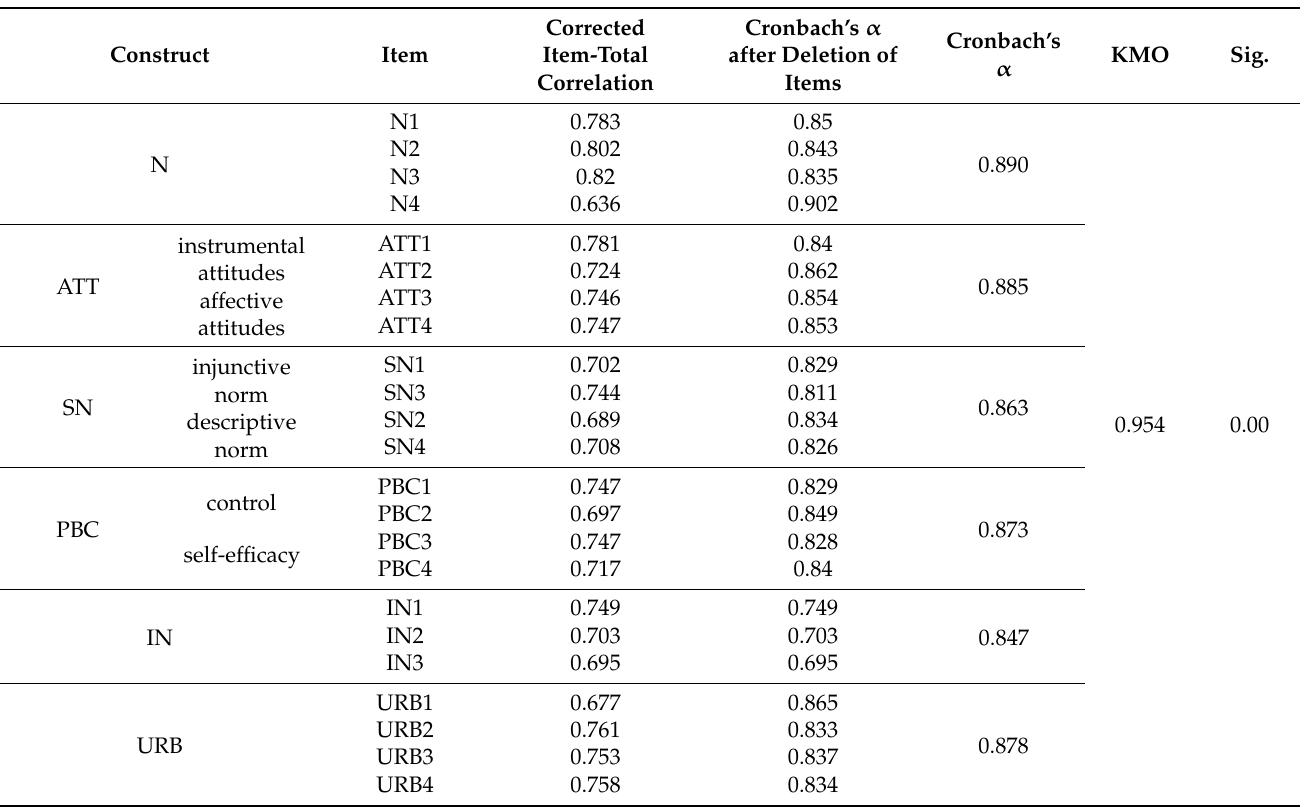
Table 2. Reliability and validity tests of the scale.